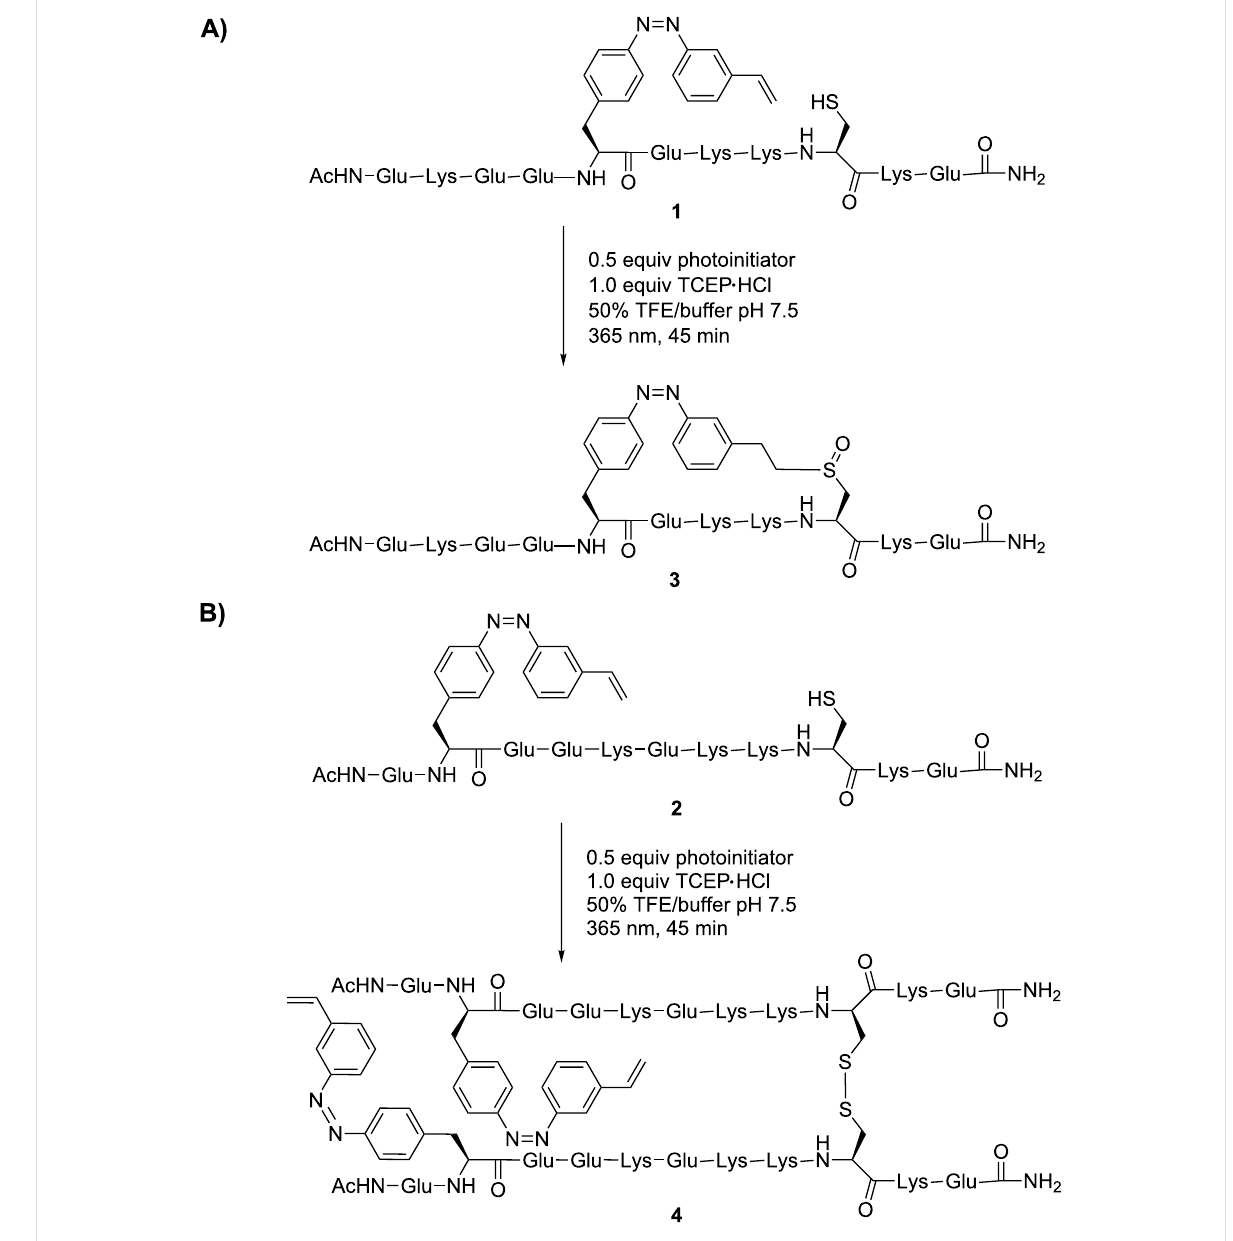
Scheme 2: Thiol–ene click reaction of PSCaa with cysteine within the helical model peptides 1 (i,i+4) and 2 (i,i+7) under structure-inducing conditions in the presence of trifluoroethanol